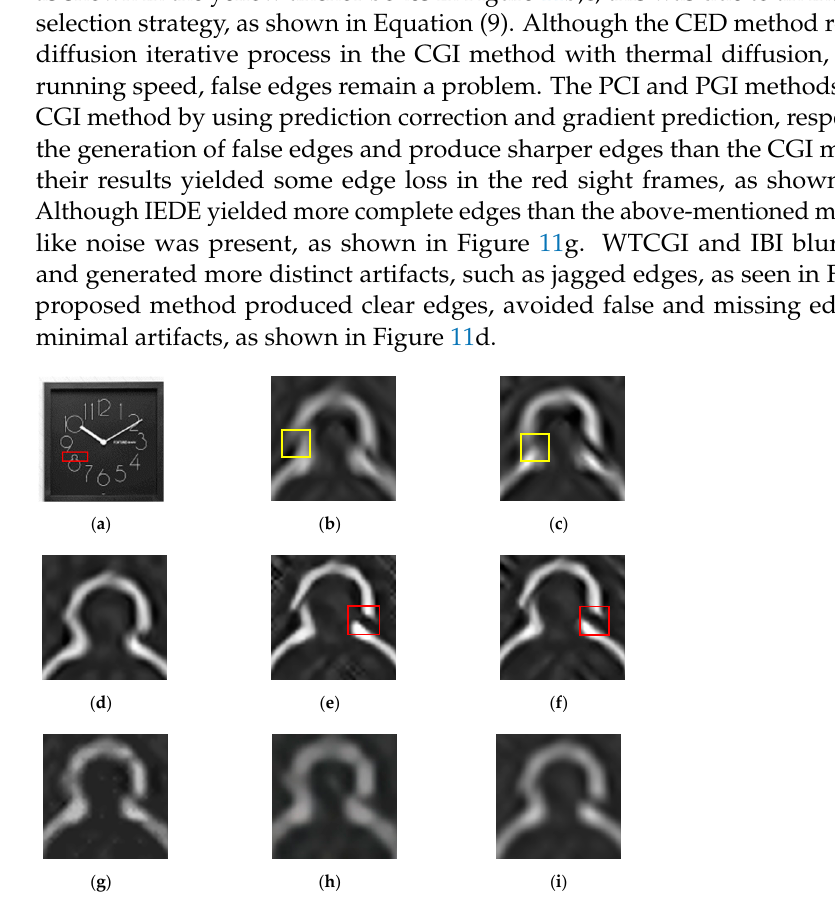
Figure 11. Comparison of interpolation results for top right part of the "wheel” image by different interpolation methods. ( a ) Upper right part of the "wheel” after interpolation; ( b ) CGI; ( c ) CED; ( d ) GEI; ( e ) PGI; ( f ) PCI; ( g ) IEDI; ( h ) WTCGI; ( i ) IBI. For the color images, CGI and the proposed method were applied to interpolate the R, G, and B channels of the color images and combine them into a single image. Figure 12 shows the interpolation results obtained by the CGI method and the proposed method for the color images ‘butterfly’ and ‘bike’. Figure 12b shows that the CGI method produced a ringing effect and artifacts in the local area. In contrast, GEI maintained the edges better in rich textural detail, as Figure 12c shows. Due to the introduction of a regional gradient estimation strategy, the proposed method had a slight advantage over the CGI method in interpolating color images.